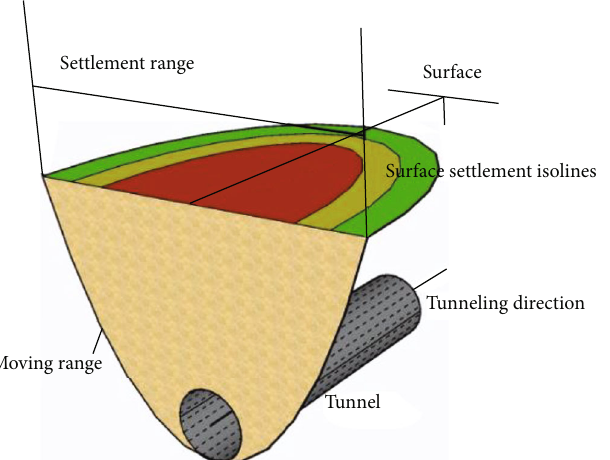
Figure 2: Spatial pattern of stratum